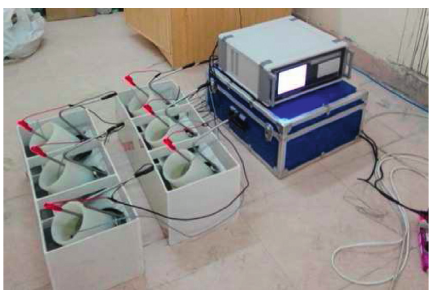
Figure 4: Overview of RCP